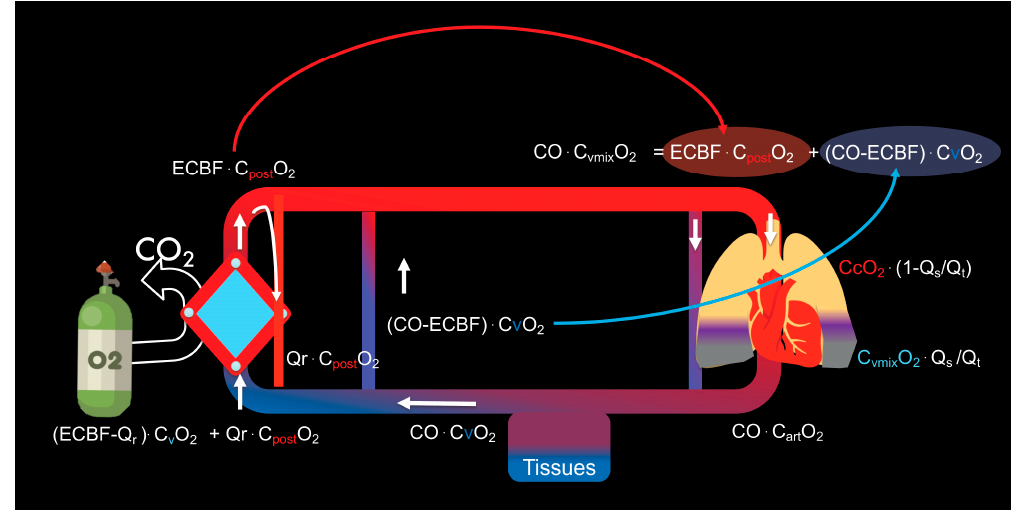
Figure 3. Schematic overview of the determinants of arterial PaO 2 . This is influenced by the degree of shunted deoxygenated blood from native lung, the ratio of ECBF to intrinsic cardiac output and amount of recirculation. Essentially, venous blood is divided into blood that is pumped through the ECMO membrane (ECBF) and an amount (Cardiac output minus ECBF) that bypasses the ECMO and mixes in the right atrium. Part of the ECBF (Qr) ‘recirculates’ back into the ECMO, decreasing the effective ECBF. Therefore, the effective ECBF (ECBFeff) is the difference between the ECBF and Qr. The oxygen content in the different compartments is illustrated.